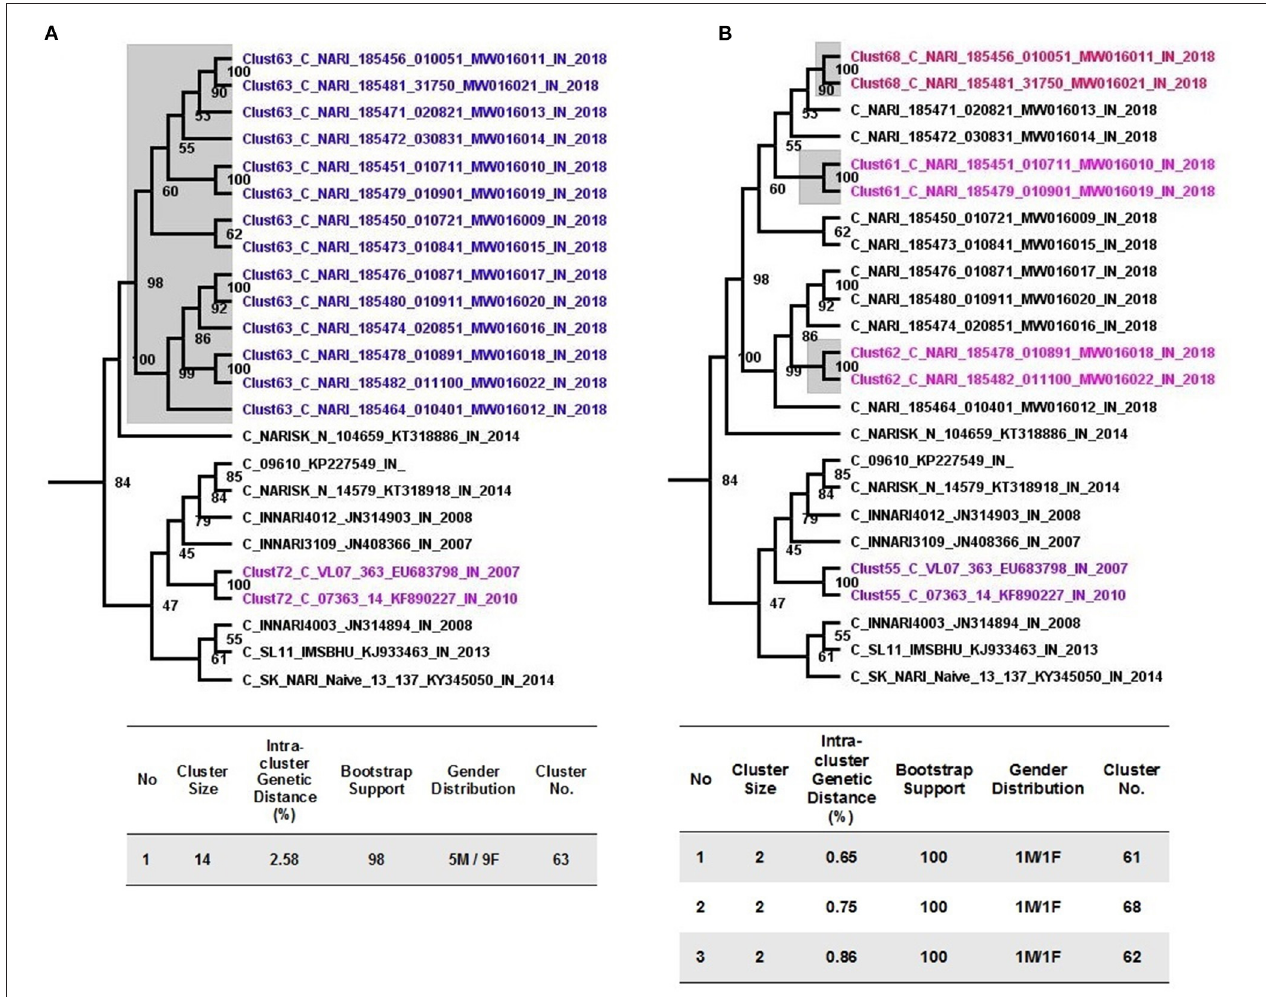
FIGURE 2 | Cluster picker analysis. (A) Unnao transmission cluster node (highlighted gray) from an annotated tree obtained after cluster picker analysis at a genetic distance of 3%. Adjoining tables enlist the properties of the cluster. (B) Recent transmission events (gray highlighted) are depicted within the Unnao transmission cluster at a genetic distance threshold of 1.5%. The adjoining table enlists the properties of the individual cluster.